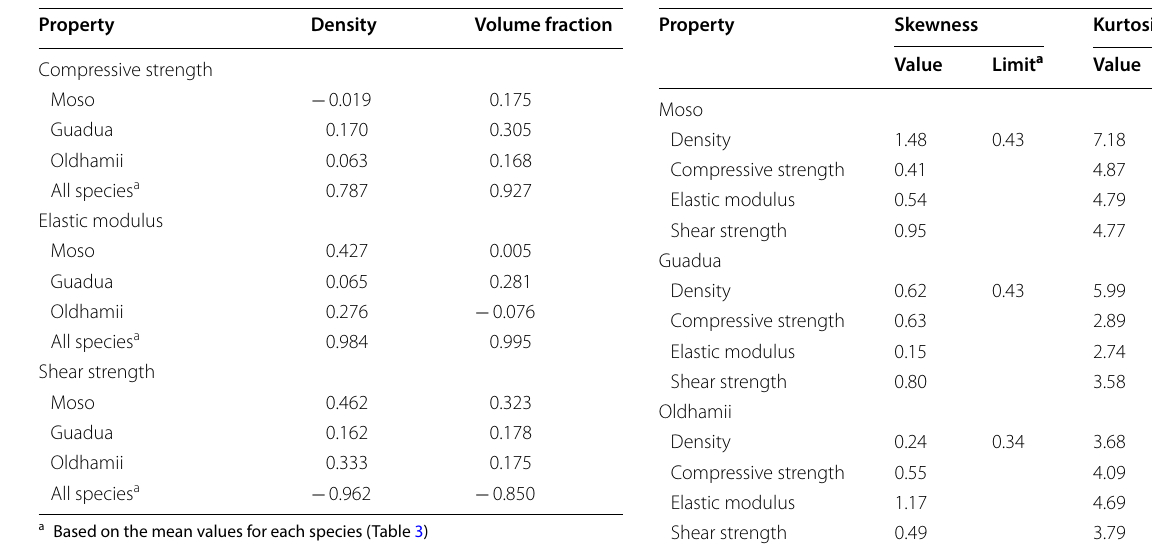
Table 5 Normal distribution directional test